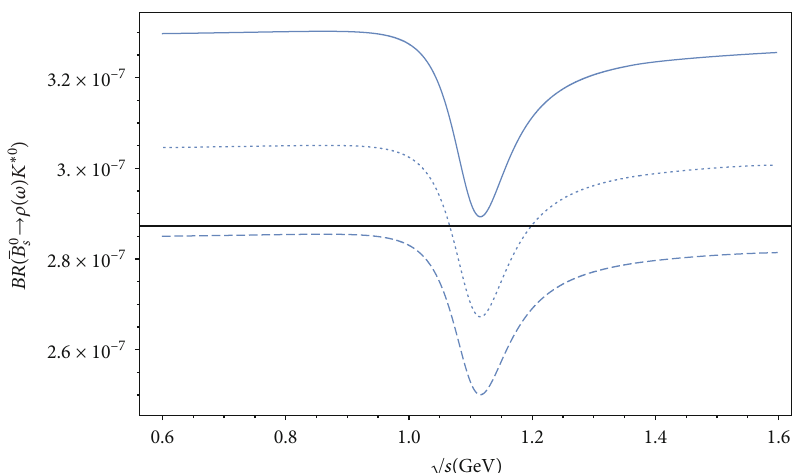
ffiffi p for the di ff erent CKM matrix elements. The solid line, dotted line, and s